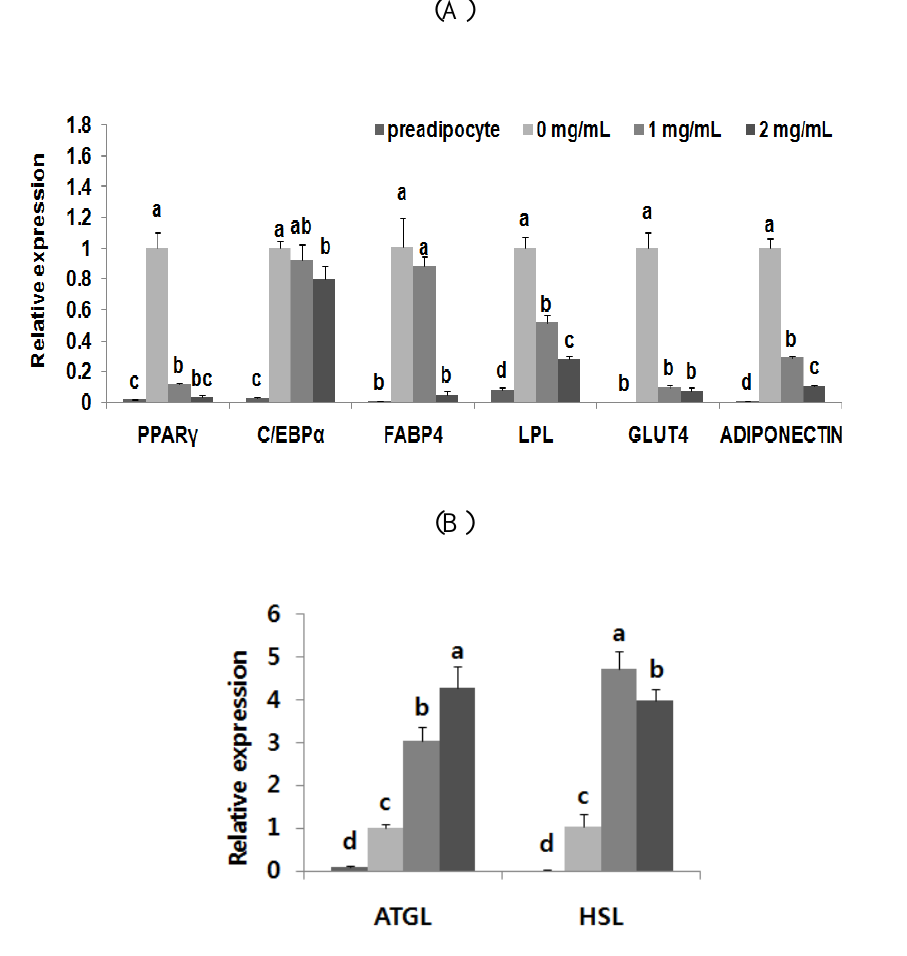
Figure 6. Effects of black adzuki bean on mRNA expression of adipogenesis and lipid metabolism-related genes in 3T3-L1 cells. 3T3-L1 preadipocyte and